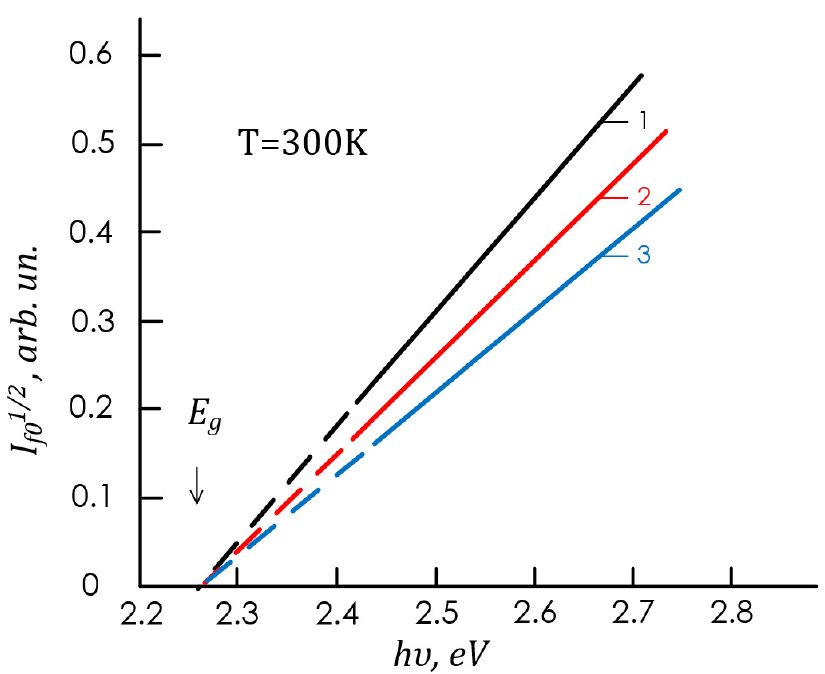
Figure 6. Dependence of the photocurrent I f01/2 related to equality of incident photons on the h ν for three Au-Pd-n-GaP surface-barrier structures with different d: 1—40 Å, 2—32 Å, 3—45 Å.